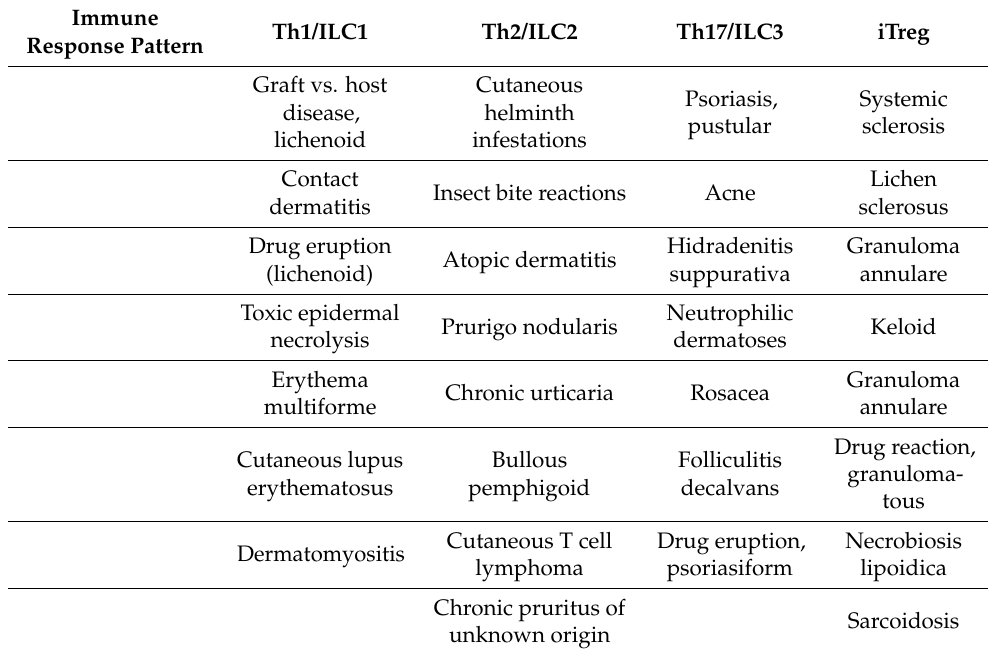
* Table legend: classification of skin disease and immune-response patterns adapted from the original concept of Eyerich and Eyerich [4]. 4. Th2 Cytokines, Chronic Itch Sensitization, and the Itch-Scratch